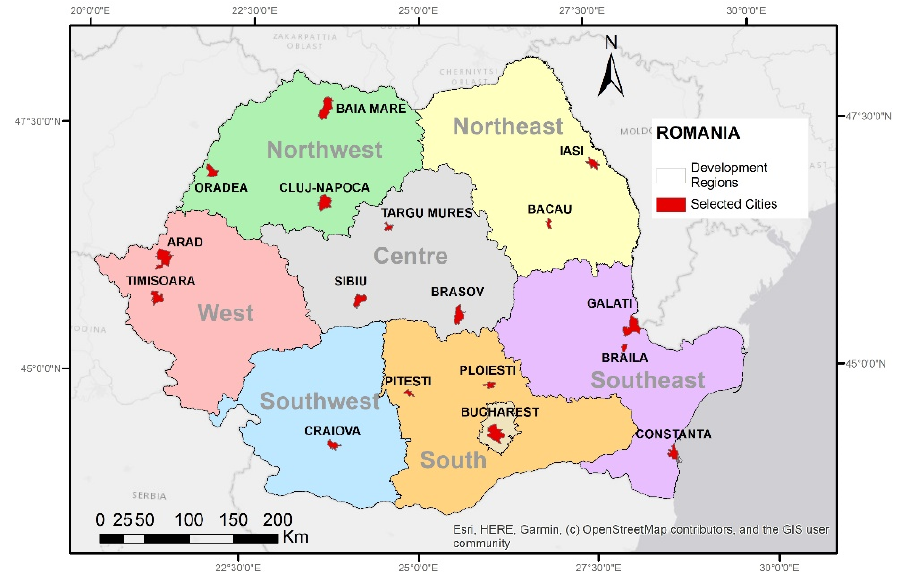
Figure 2. The location of the chosen 17 cities on the Romanian map. Map generated in Esri ® ArcMap™ 10.3. Base map source: ESRI. Source: elaborated by the authors. Table 1. Summary of the selection criteria.